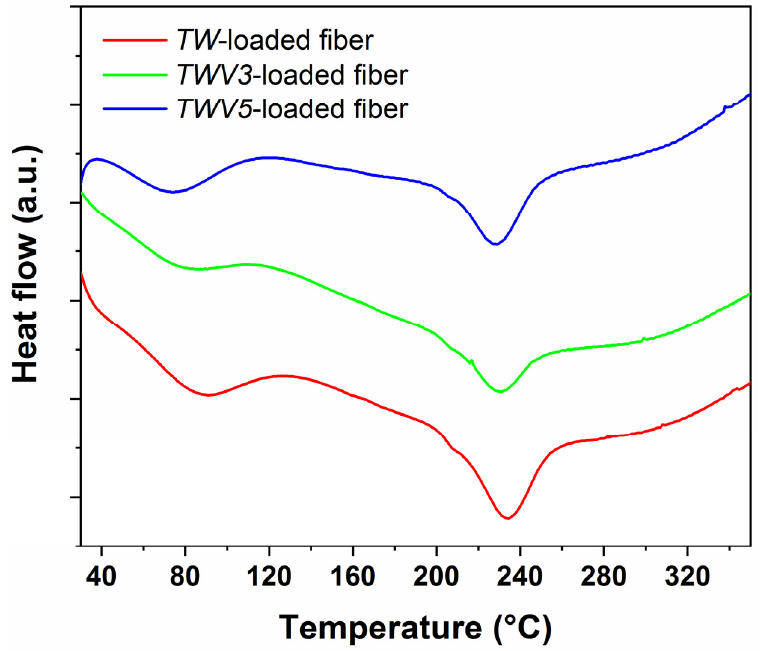
Figure 8. DSC curves of MON − supported fibers. Figure 6. DSC curves of MON-supported